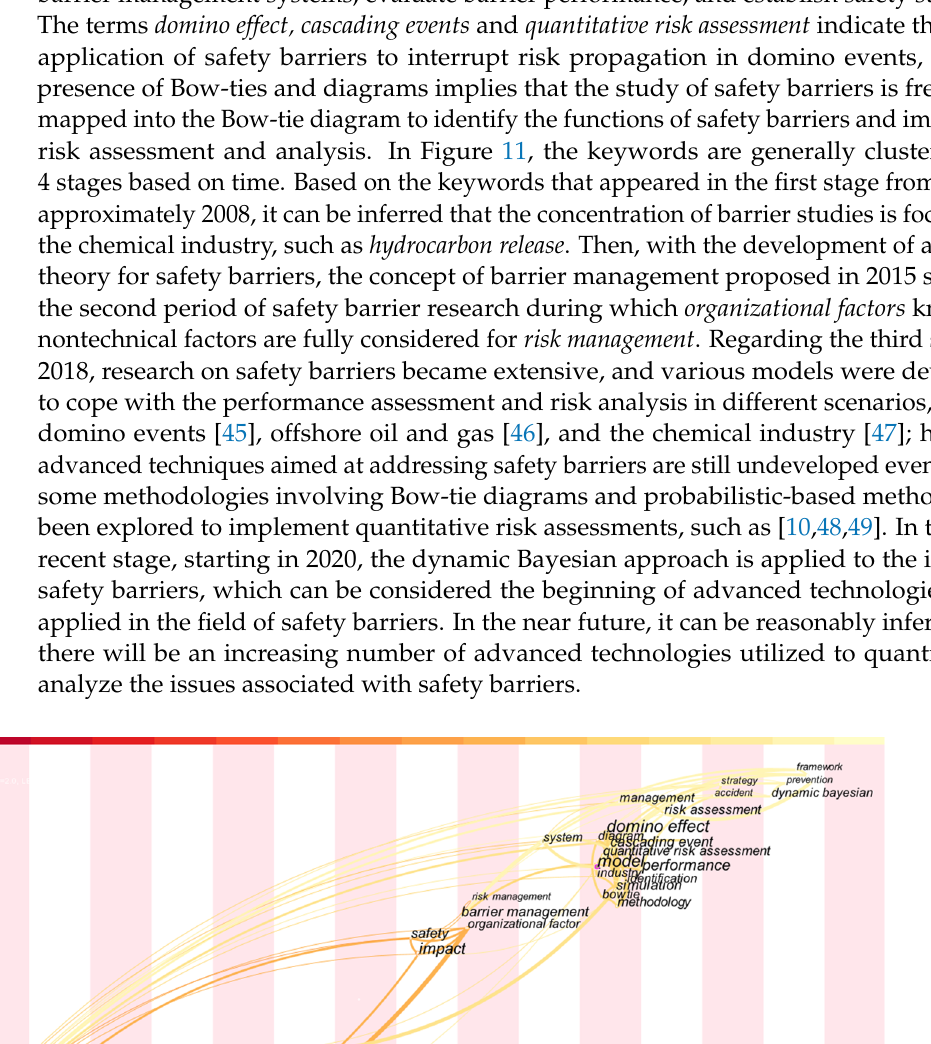
Figure 11. Evolution diagram based on keyword cooccurrences.